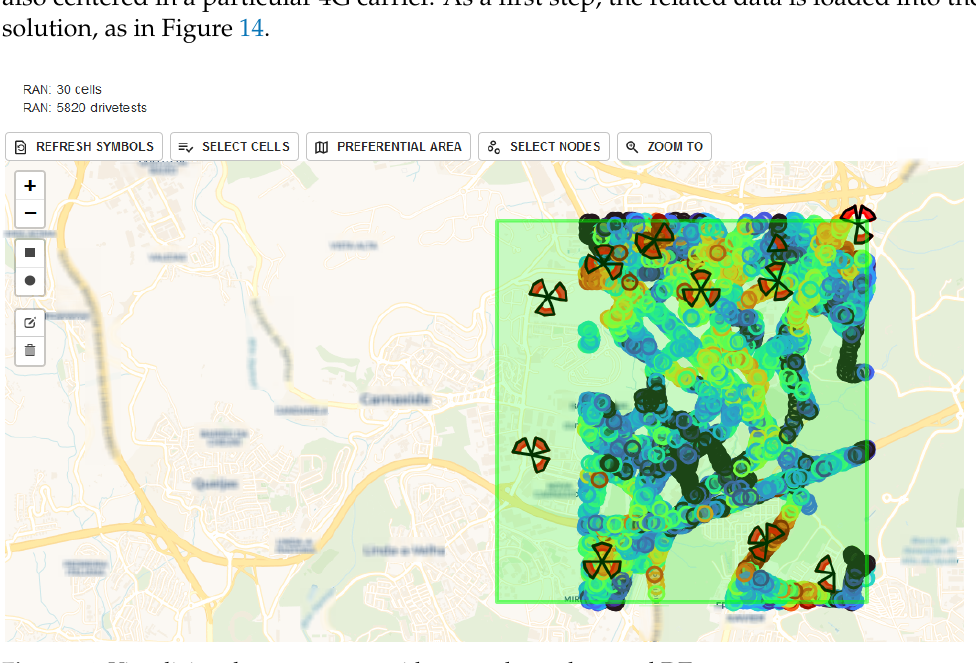
Figure 14. Visualizing the target areas with network topology and